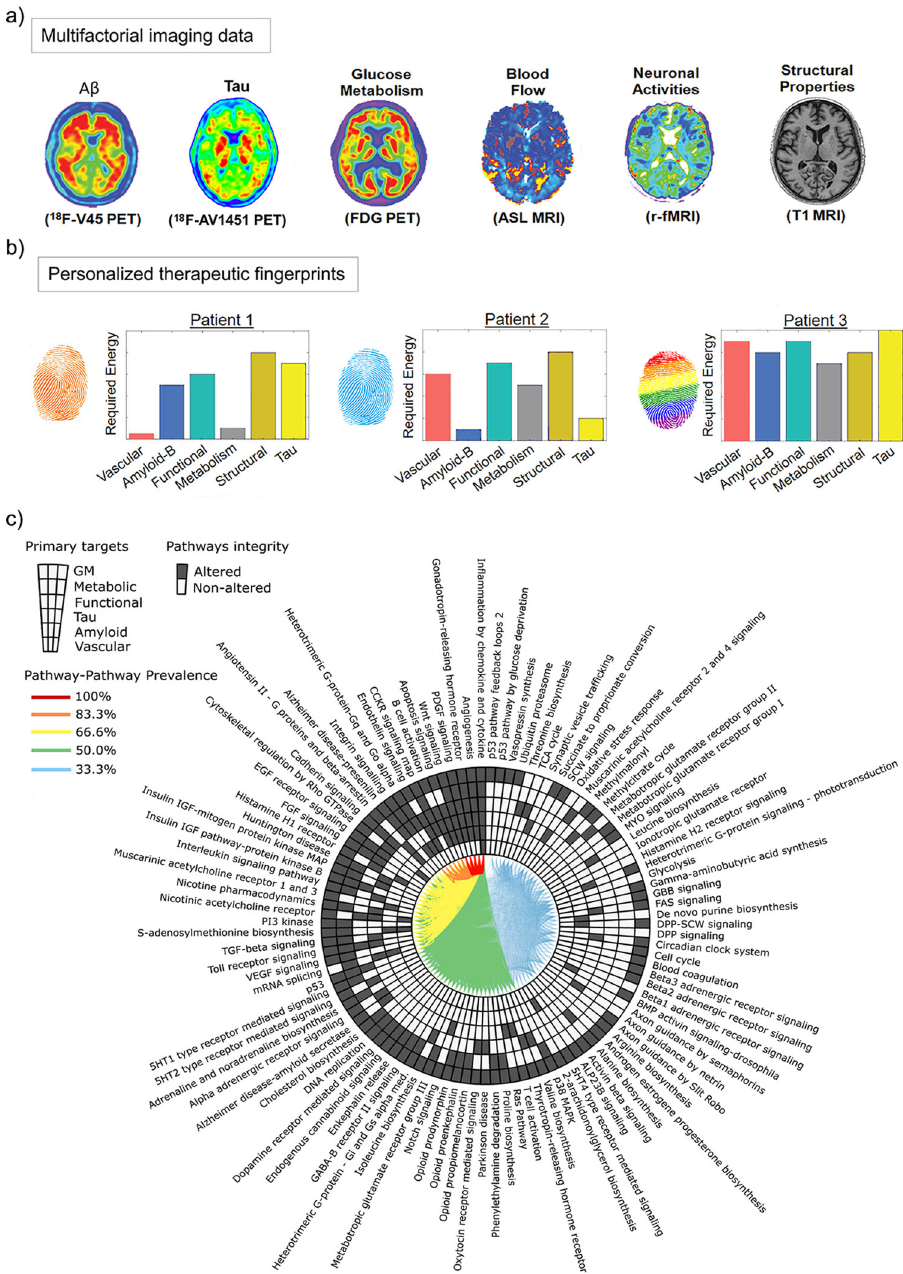
Fig. 5 From multimodal imaging to therapeutic fi ngerprints and altered molecular pathways (ADNI data). a Imaging for amyloid, tau, CBF, functional activity at rest, glucose metabolism, and gray matter density. Based on a network-based approach 14 , pTIF enables individual characterization of the direct factor-to-factor intra-brain biological interactions and the multifactorial spreading mechanisms through vascular/anatomical connections. Inverting its fundamental equation provides an estimation of the changes required to produce a desired state (e.g., healthy); hence, the pTIF is de fi ned as the set of changes required for each patient. b Dissimilar pTIF patterns for three participants with the same diagnosis. Patient 1 requires low-cost vascular and metabolic interventions and Patient 2 requires low-cost interventions for anti-Aß and anti-tau interventions, suggesting different single-target therapies could bene fi t both patients (e.g., physical exercise and aducanumab, respectively). However, Patient 3 requires multiple single-target interventions, suggesting that a high-cost combinatorial treatment, as opposed to a single-target treatment, would be more bene fi cial for this patient. c The altered molecular pathways (blood data) underlying the distinct single-target therapeutic needs. Starting at 12 o ’ clock and moving counter-clockwise, the pathways for each of the single-target subgroups were sorted according to prevalence. Each link between a given pair of pathways corresponds to the percentage of subgroups for which molecular pathways were found to be affected. Images ( a – c ) adapted with permission from ref. 15